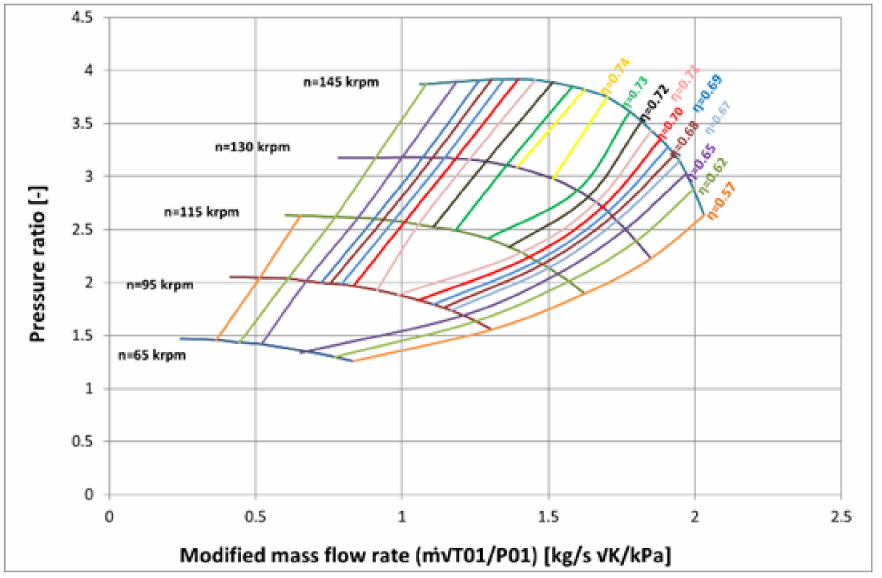
Figure 6. Compressor performance map